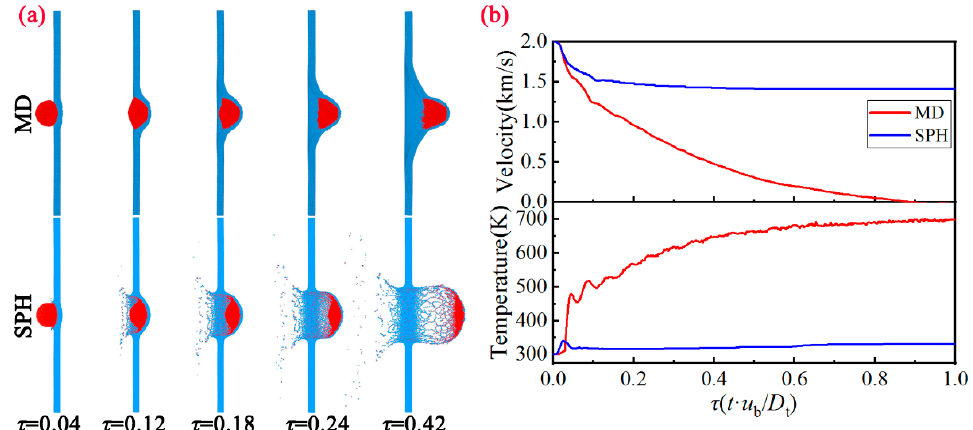
Figure 3. ( a ) Evolution of the debris cloud morphology between MD and SPH at different moments under u b = 2.0 km/s. ( b ) Comparison of the velocity and temperature variation with time between MD and SPH.